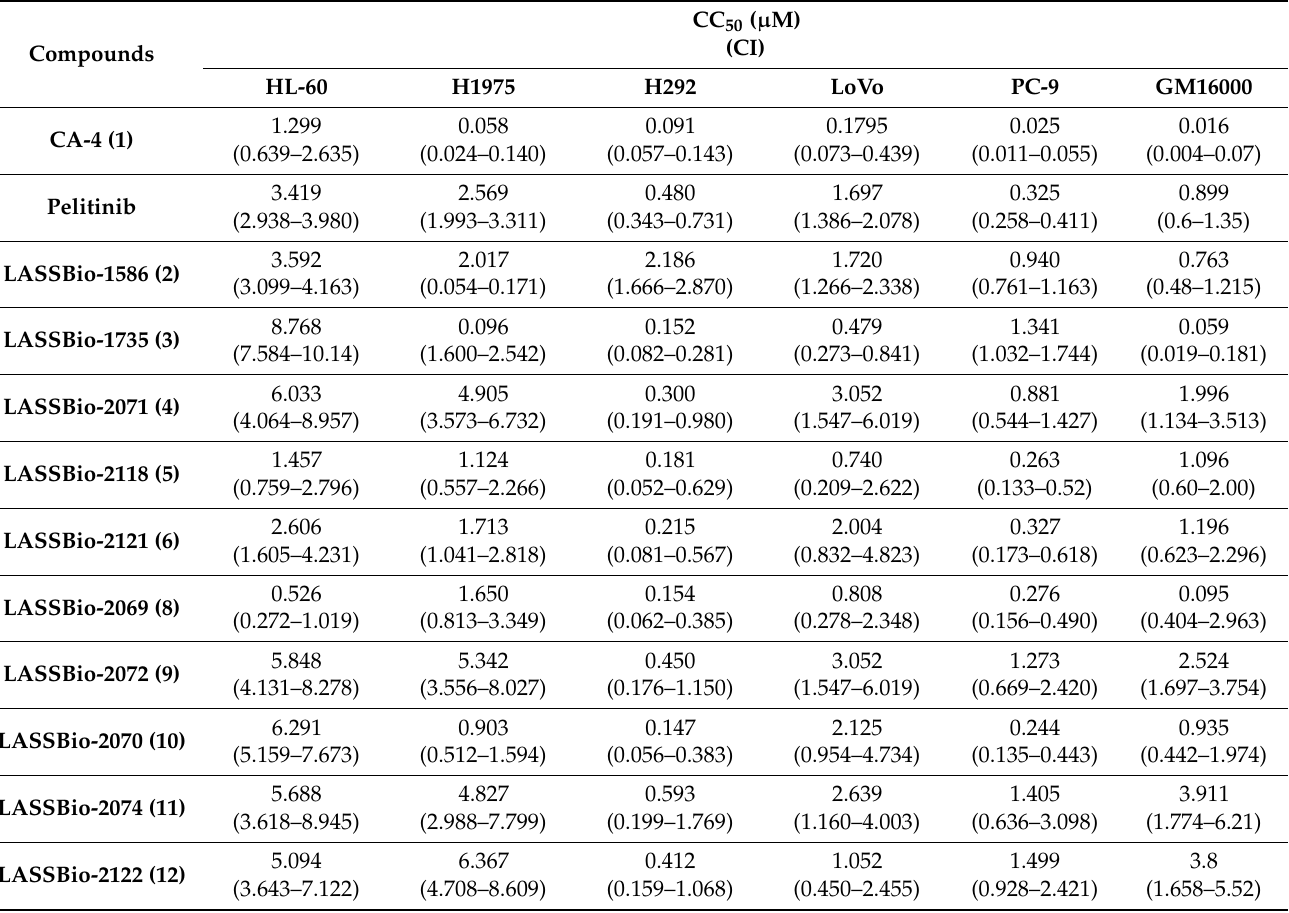
Table 4. Cytotoxic potency activity (mean CC 50 ± CI) of compounds 3 – 12 , and the standards CA-4, pelitinib and LASSBio-1586 ( 2 ), against tumor cell lines and GM16000 at 48